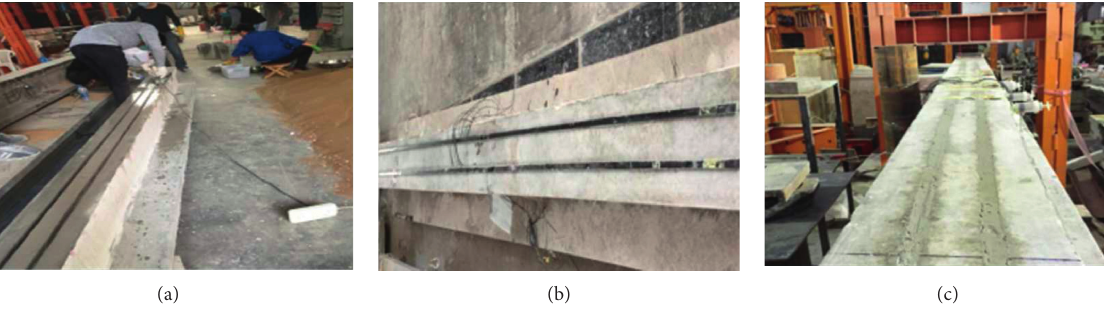
Figure 3: Reinforcement process of specimens: (a) grooving, (b) strip cutting, and (c) strips